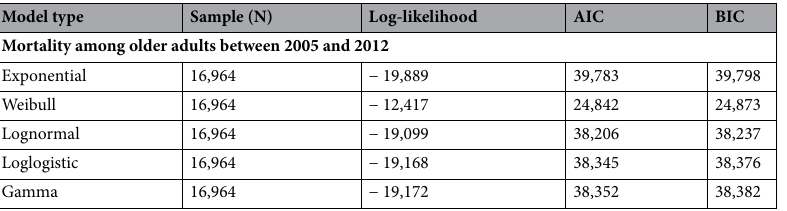
Table 3. Measures of goodness-of-fit for three-level random intercept survival regression models of mortality among older adults in India. AIC, Akaike information criterion; BIC, Bayesian information criterion.